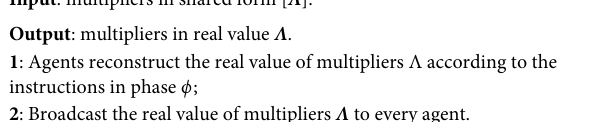
Algorithm3 Reconstruct multipliers Λ of coupled constraints in real